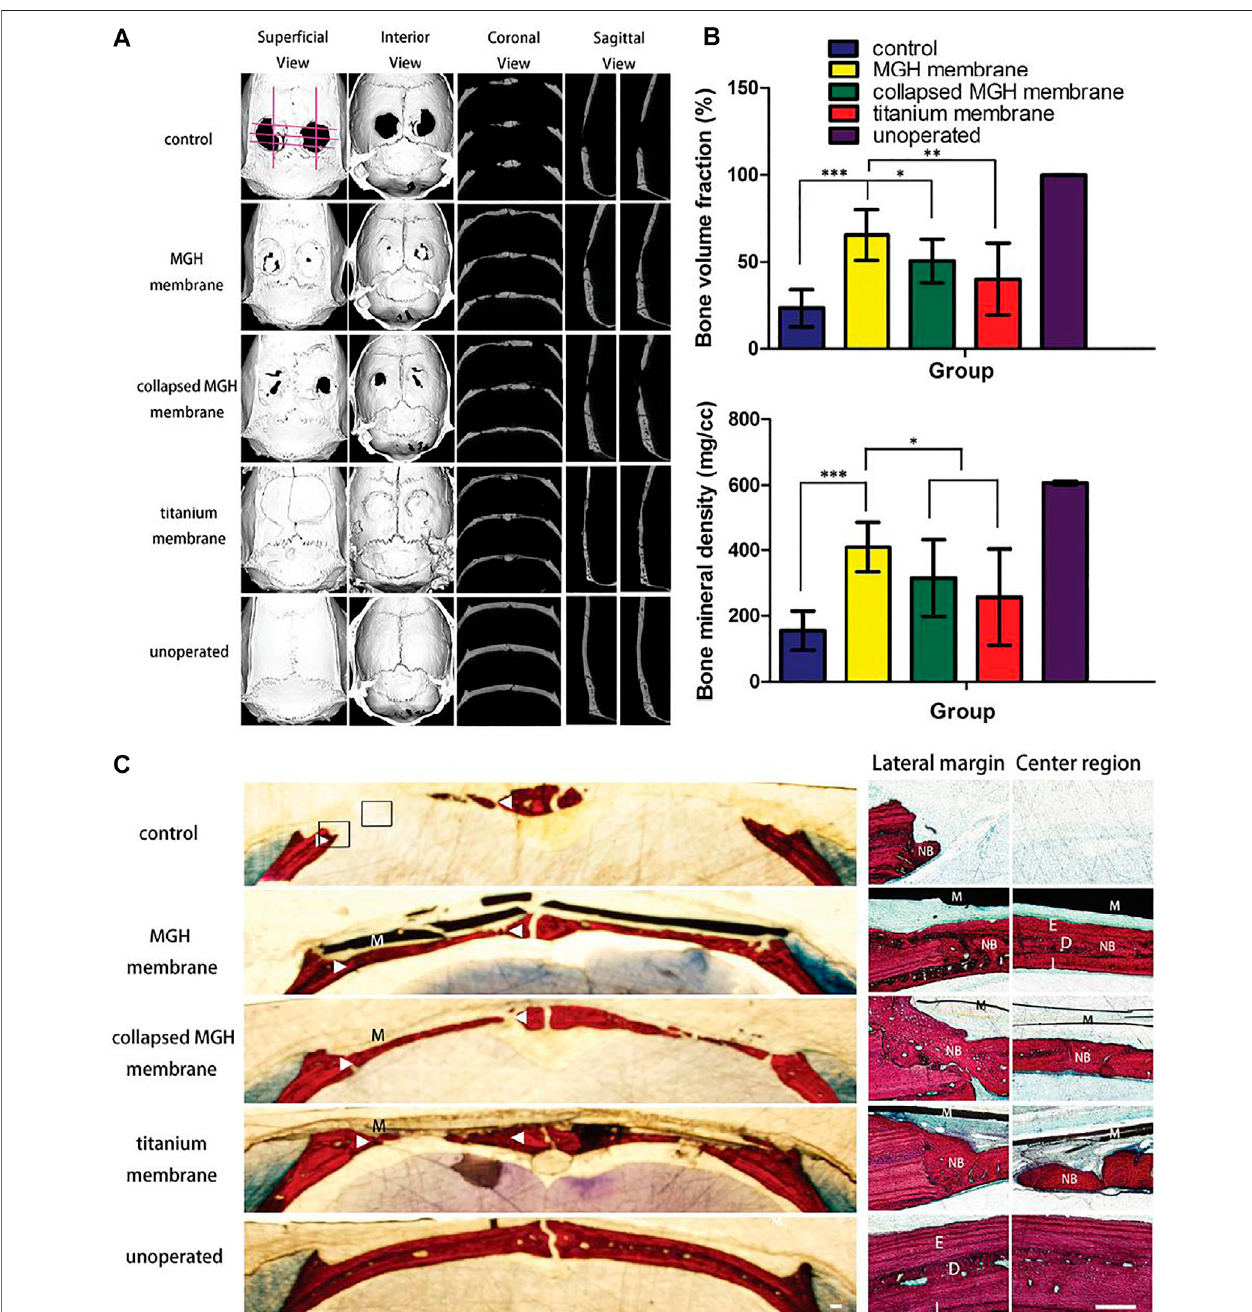
FIGURE 4 | The bone regeneration 8 weeks after surgery. (A) Micromorphometric analysis of treated calvarial defects including super fi cial, interior, coronal, and sagittal section views of micro-CT images taken at the eighth week after surgery. (B) Micromorphometric bone parameters including bone volume fraction and bone mineral density analyzed after8 weeksofsurgery. Note thatboth thebone volume fraction and mineraldensity oftheMGH membranes grouparehigher than therestof the groups analyzed. (C) Van Gieson ’ s staining of calvarial undecalci fi ed sections after 8 weeks of implantation. Low-magni fi cation histological images (left) showed osteogenesis of the testing groups with/without barrier membranes (M). High magni fi cation histology (right) showed boxed areas in the left images, both the lateral margin and center region of defects. In the MGH membrane group, the newly formed bone (NB) exhibited a mature lamellar bone structure with external cortical bone (E),diploic bone (D), and internal cortical bone (I)all discernable. Trianglesdenote the originalbone margins. Scale bars, 250 μ m. Reproduced from Lu et al.(2016) with permission from Copyright 2016 Wiley.